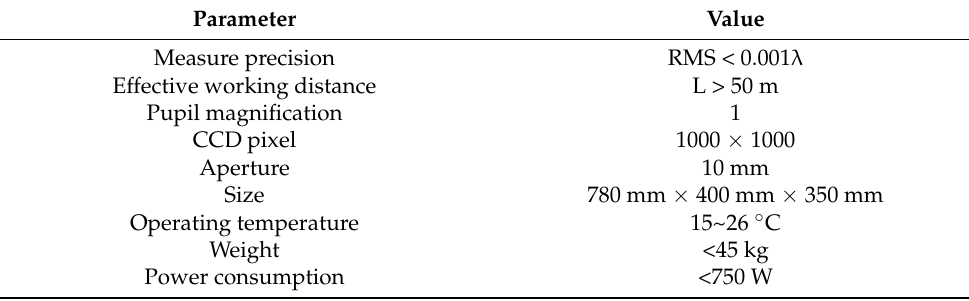
Table 3. Performance parameters of the Fizeau-interferometer.